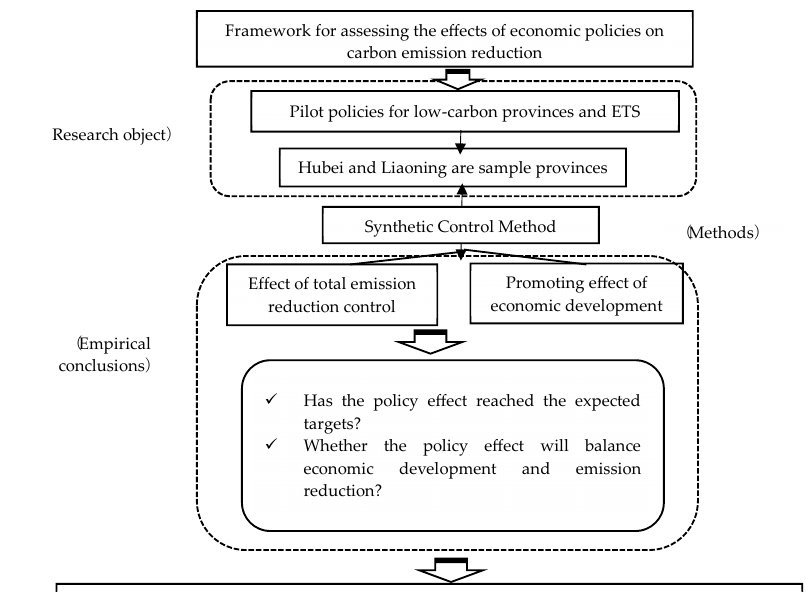
Figure 1. Research